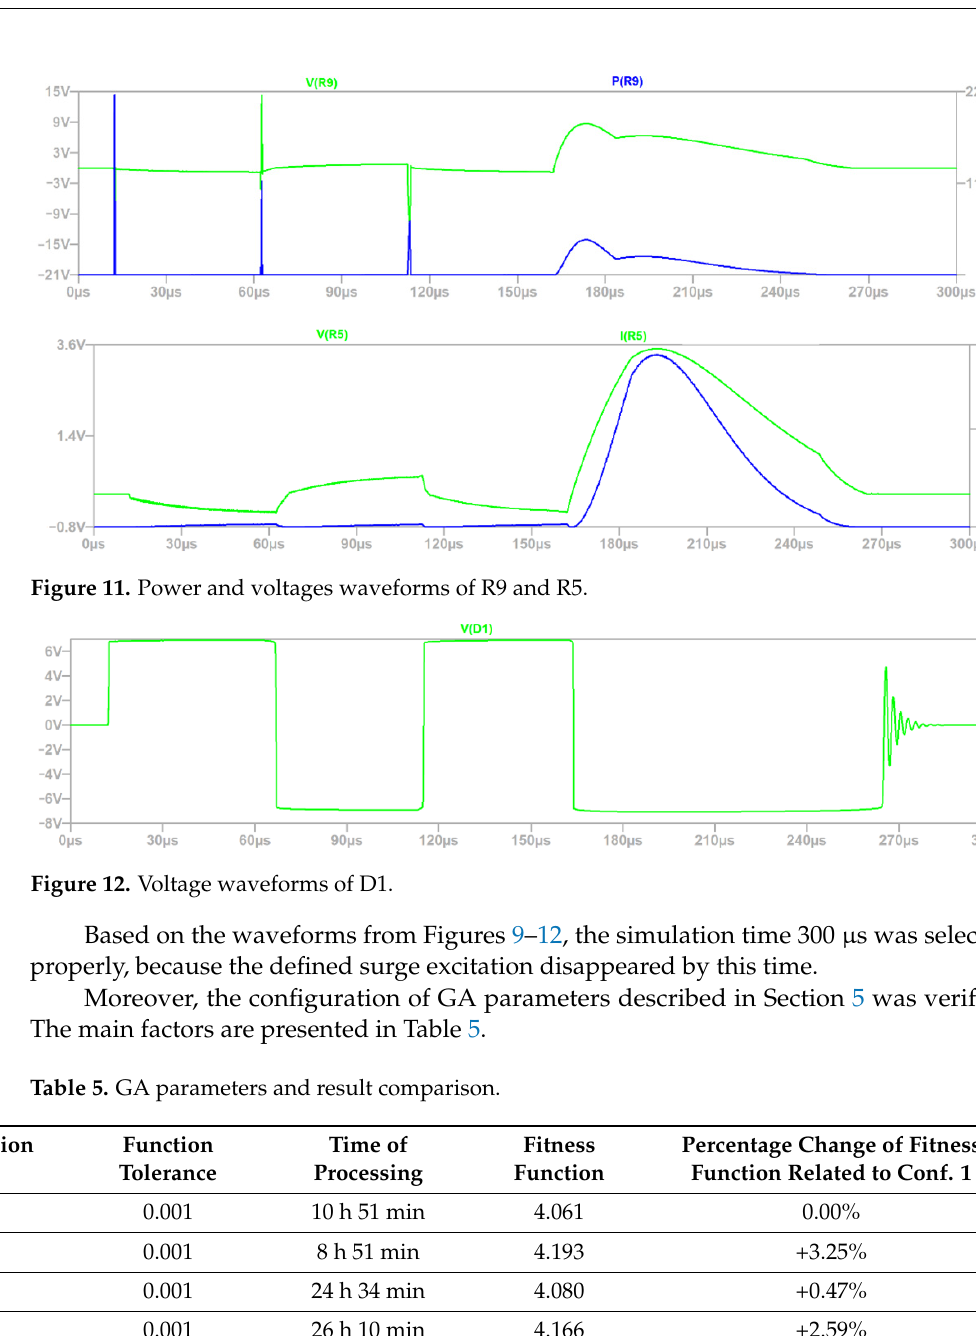
Figure 12. Voltage waveforms of D1. Table 5. GA parameters and result comparison.